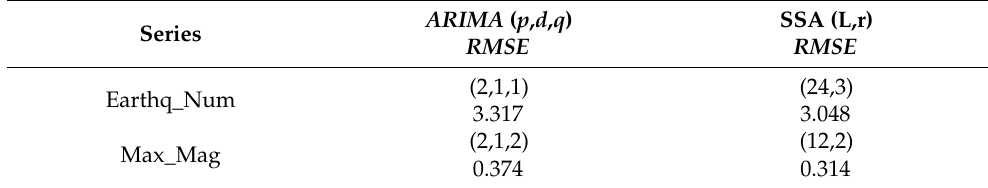
Table 3. Best model selected based on the RMSE value for the two considered time series. ARIMA ( p , d , q ) Series